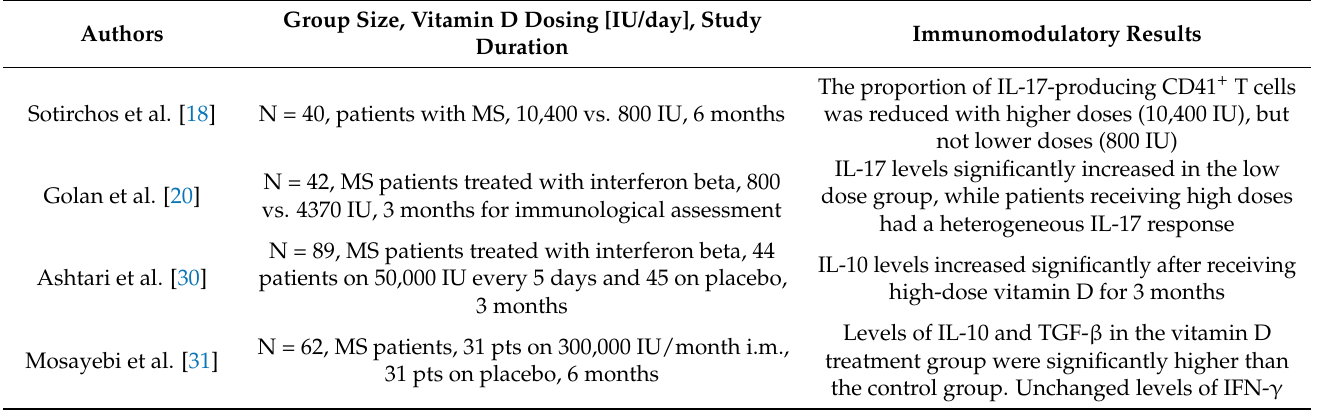
Table 5. Summary of selected vitamin D supplementation studies in patients with